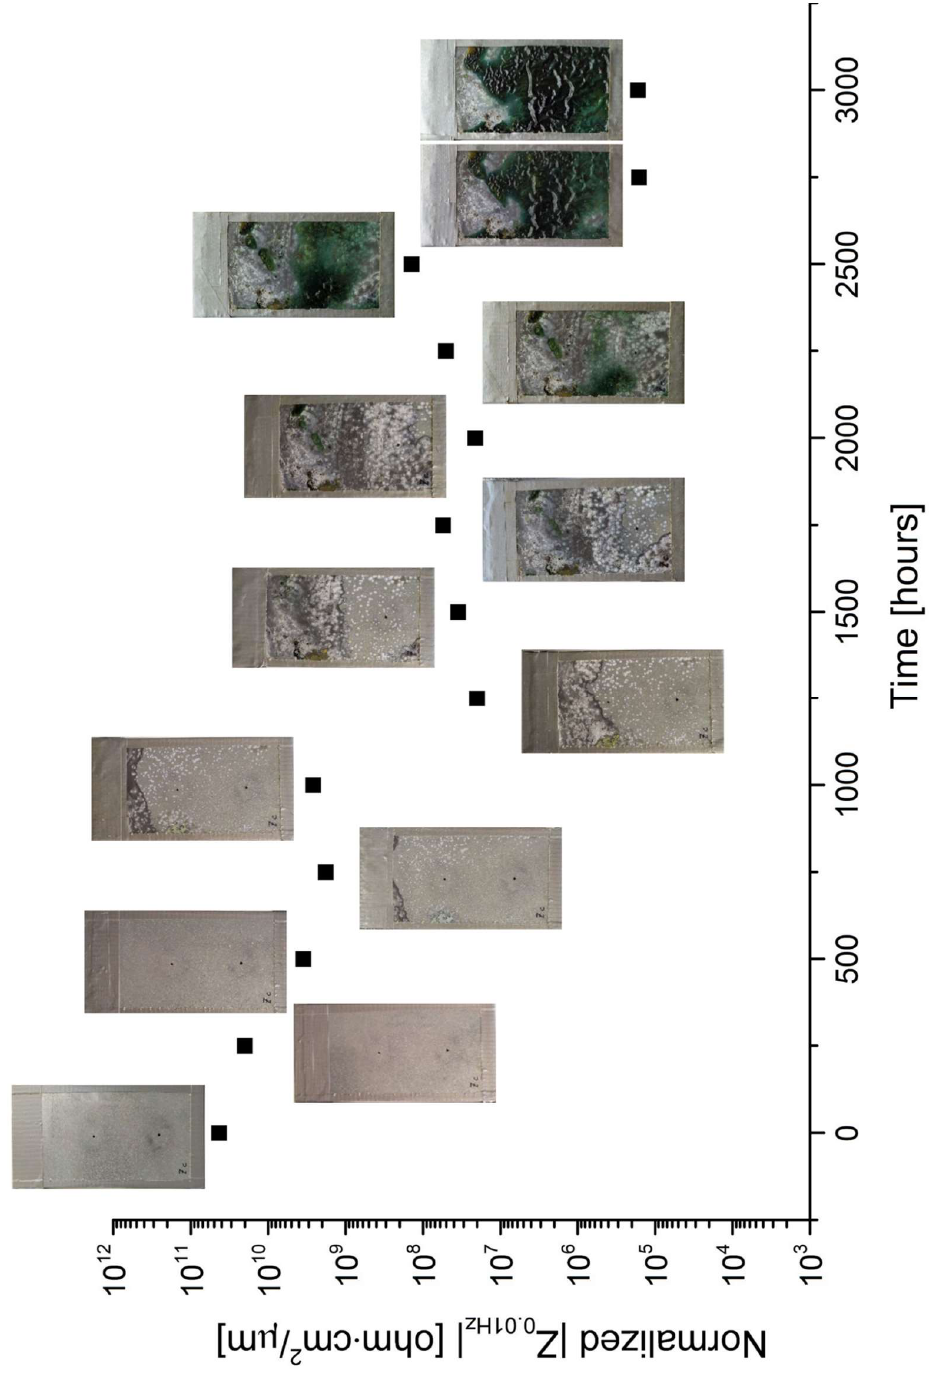
Figure 13. Example of impedance modulus evolution in time and the corresponding corrosion evo- evolution during the prohesion test for painted HDG lution during the prohesion test for painted HDG steel.